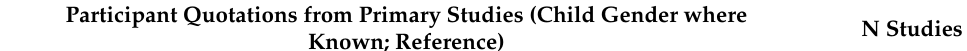
Table 4. Illustrative quotations and references reporting each of the subthemes for ‘Why do children think physical activity is